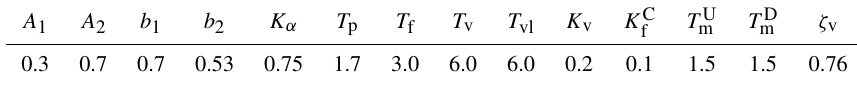
Table 3. Constants applied for the IAG model.